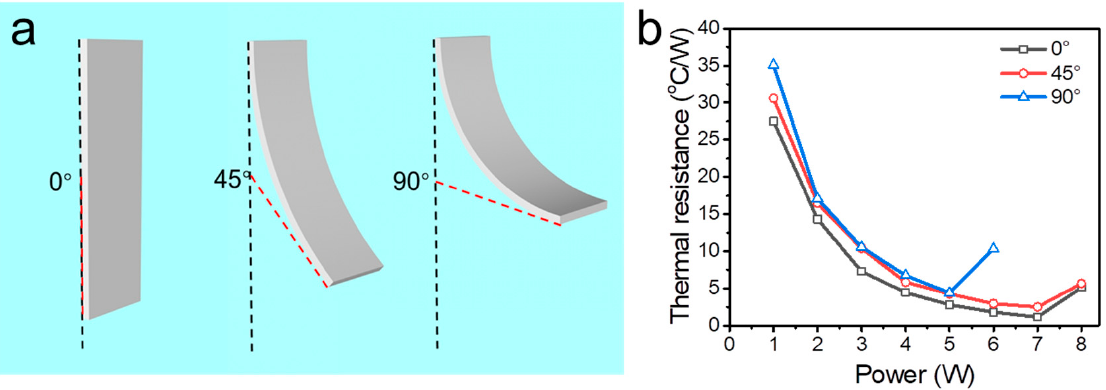
Figure 6. Thermal performance of the FOHP at different bending angles. ( a ) Schematic of the bent FOHP. ( b ) Thermal resistance evolution at different bending angles.